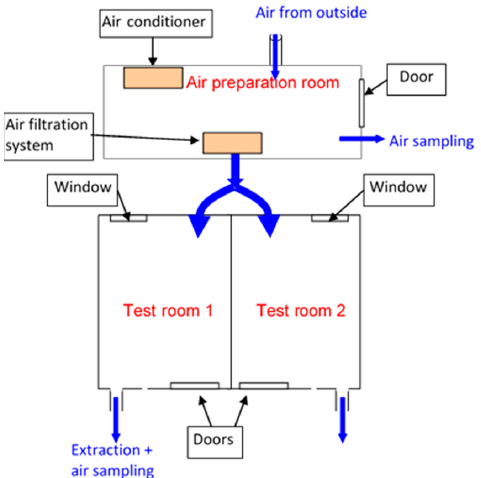
Figure 3. Schematic drawing of the full-scale test chamber in the Insulation Research and Development Center (CRIR).